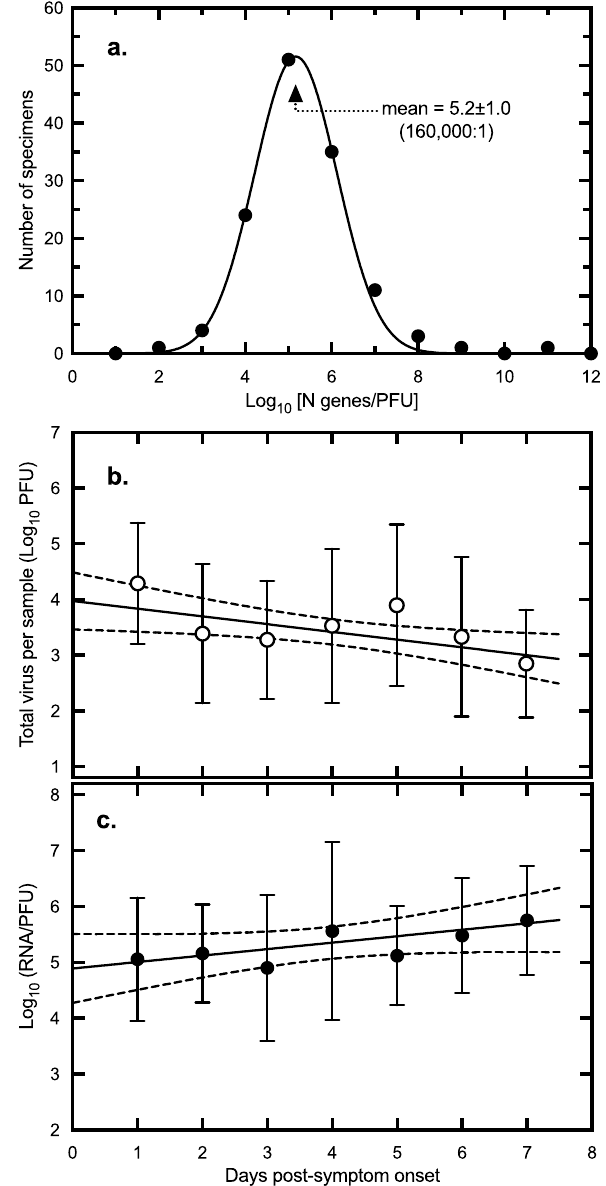
Figure 8. Relationship between viral RNA quantity, PFU, and sample timing. ( a ) The ratio of RNA to PFU was calculated using the virus titer plus a determination of the number of N-gene copies across all of the specimens. The ratios were log 10 transformed and the distribution calculated across bin steps of one log 10 . A non-linear fit of a Gaussian curve to these data is also shown, centered on a mean of 5.2 ± 1.0 SD. This represents 10 5.2 = 160,000 RNA copies per PFU. ( b ) The total quantity of virus in each infectious specimen was calculated using the titer (PFU/mL) and the known collection volumes (i.e., specimen + carrier/diluent). These values were then averaged across all of the samples for each of the indicated days. The plot shows a linear regression fitted to the log 10 -transformed data along with the 95% confidence intervals (y = − 0.14x + 4.0, goodness of fit r 2 = 0.05). The negative slope is significantly non-zero ( P = 0.015, F-test). Error bars represent standard deviation. The average virus load declined about tenfold over the course of a week beginning at ~ 10 4.0 PFU/mL on a hypothetical day zero. ( c ) The relative infectivity was calculated using the virus titer (PFU/mL) and specific quantity of virus RNA/mL in each sample. The plot shows a linear regression fitted to the log 10 -transformed data along with the 95% confidence intervals (y = 0.12x + 4.9; goodness of fit r 2 = 0.04). The positive slope is significantly non-zero ( P = 0.032, F-test). Error bars represent standard deviation. The ratio of RNA/PFU increased about eightfold over the same seven days, starting at ~ 10 4.9 RNA/PFU on day zero. Figure prepared using Prism v9.3 (https:// www. graph pad.